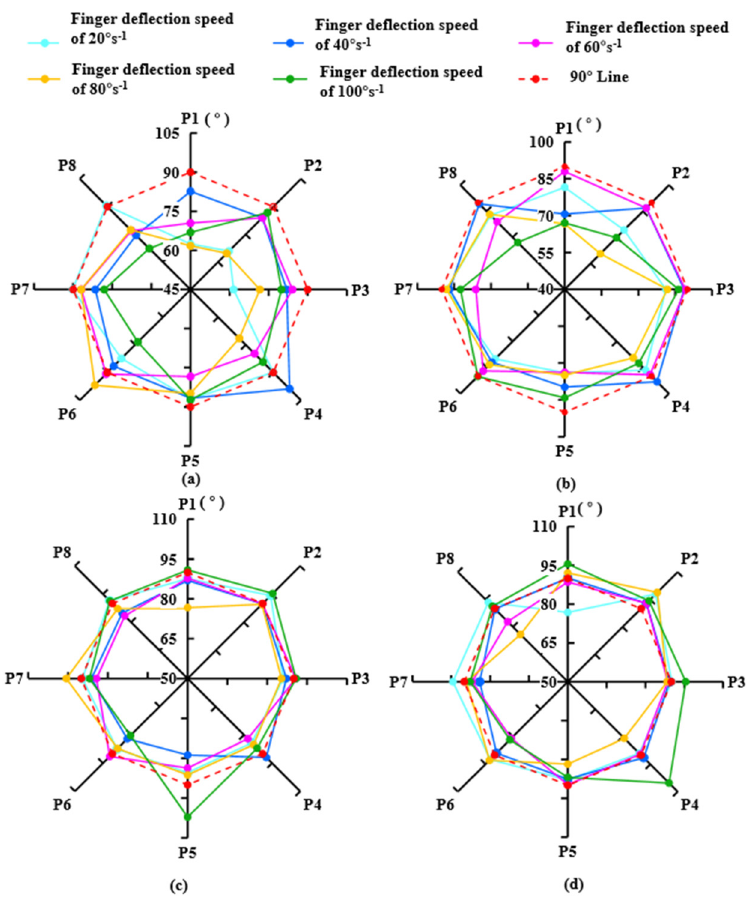
Figure 16. Test results for grasping inclination angle: ( a ) the results for 30° to 45° inclination angle at different initial position P i and different finger deflection speed, ( b ) the results for 45° to 60° inclination angle at different initial position P i and different finger deflection speed, ( c ) the results for 60° to 75° inclination angle at different initial position P i and different finger deflection speed , and ( d ) the results for 75° to 90° inclination angle at the different initial position of P i and different finger deflection speed .